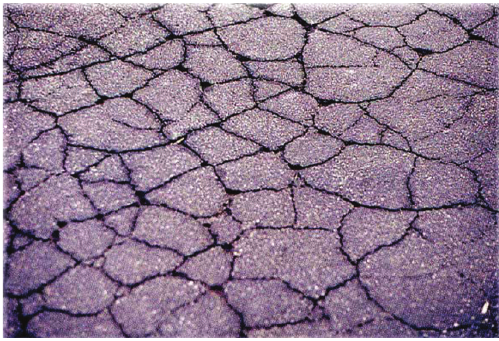
Figure 11: Fatigue